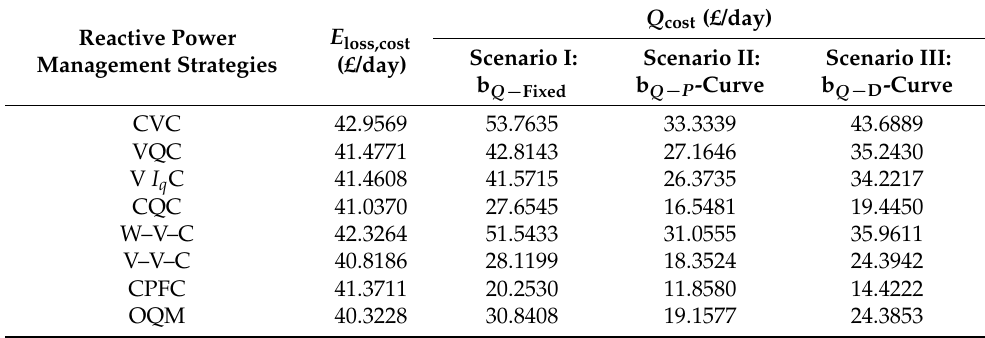
Table 5. Day-ahead cost of the energy losses and the reactive power injected by the DER at the PCC. Reactive